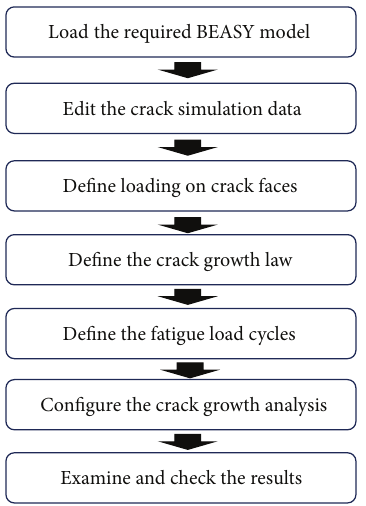
Figure 6: Crack setting location of an uncorroded oil pipe but with cracks resulting from the production.